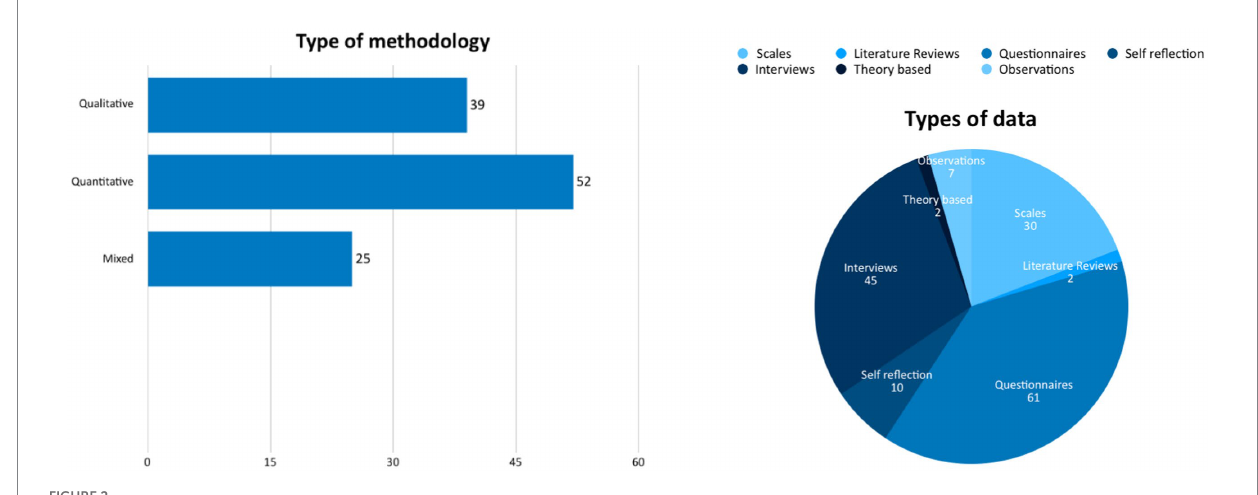
FIGURE 2 Distribution of research design and